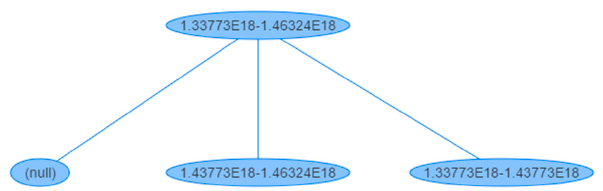
Figure 13. Hierarchy id.